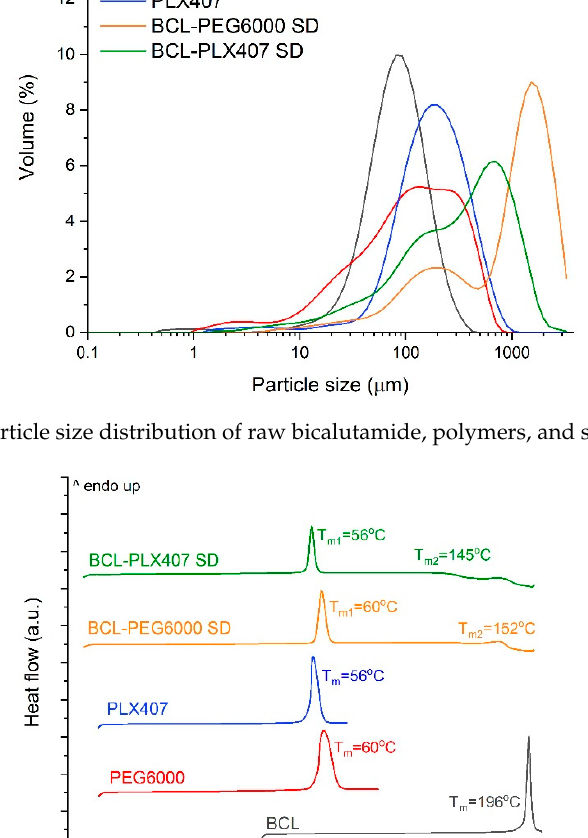
Figure 2. The particle size distribution of raw bicalutamide, polymers, and solid dispersions.